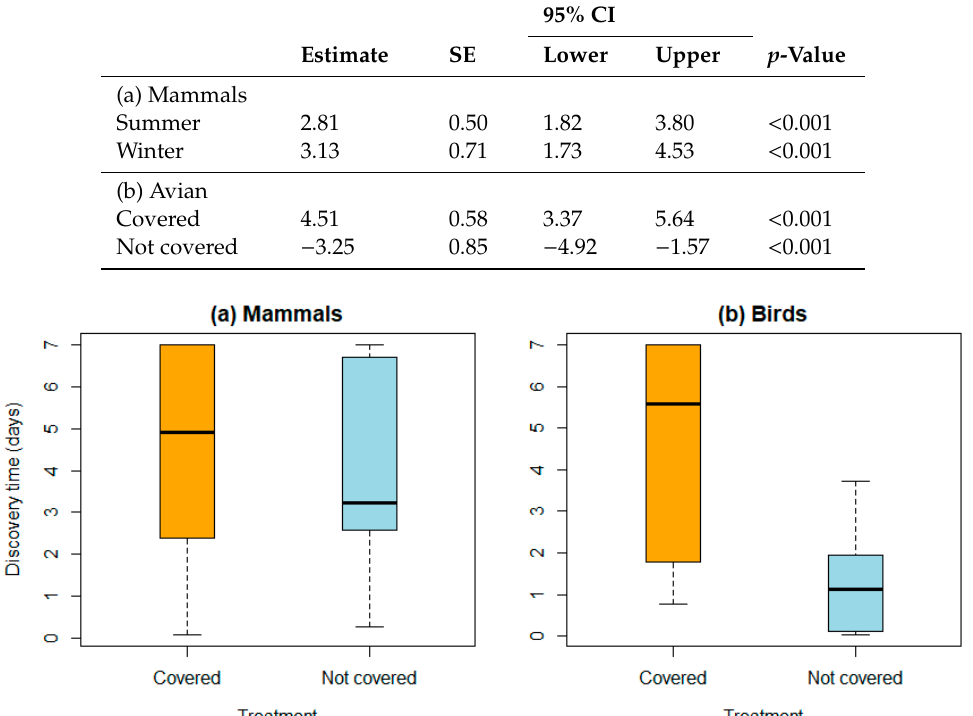
Table 1. Estimates of model (selected by model reduction) explaining discovery time for (a) mammalian and (b) avian scavengers of 26 carcasses with season of placement, treatment (covered vs. not covered (NC)) and their interaction as explanatory variables.